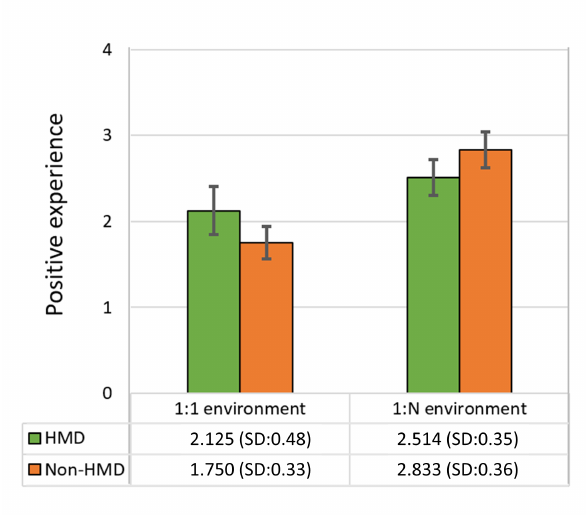
Figure 12. Mean (SD) of the results for the post-game module of the experience questionnaire (GEQ). According to the results for positive experiences, non-HMD players in a one-to-many environment reported higher scores than those playing in a one-to-one